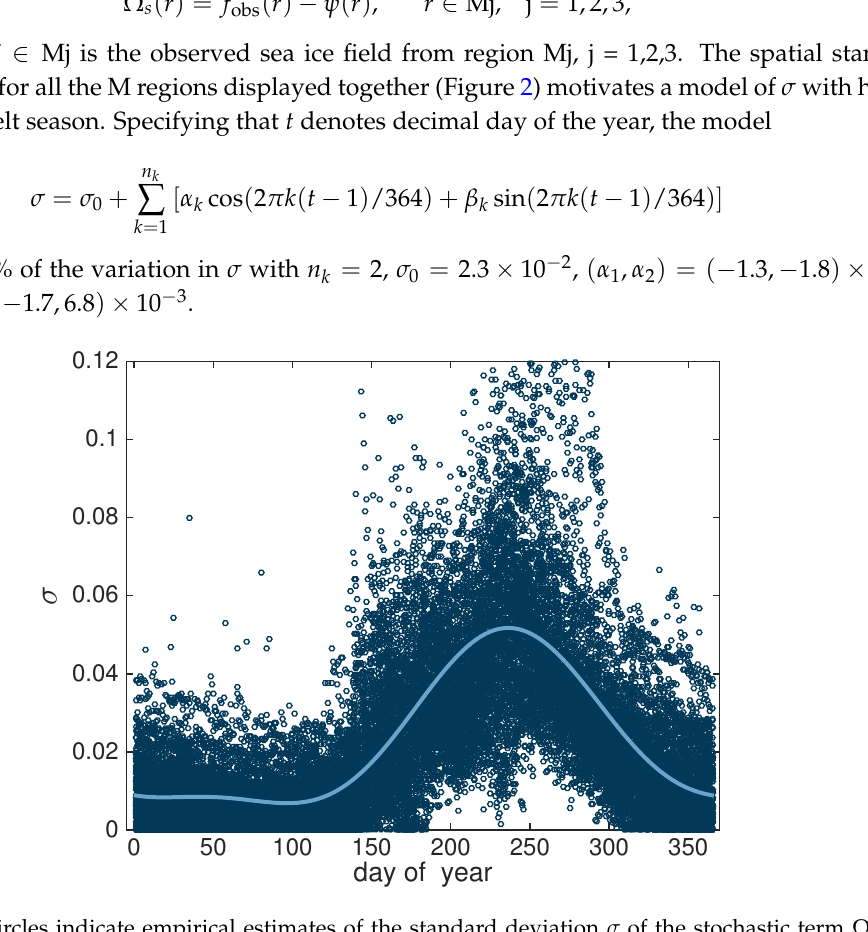
Figure 2. Circles indicate empirical estimates of the standard deviation σ of the stochastic term Ω , as a function of day of the year for 1988–2013, where 1988 is selected because it is the first full year after adoption of the moderately-sized pole hole mask (radius 311 km, Table 1). The curve is a fit of Equation (4) with k = 2. Values exceeding 0.12 (less than 1% of the data) are not shown, but were included in the curve